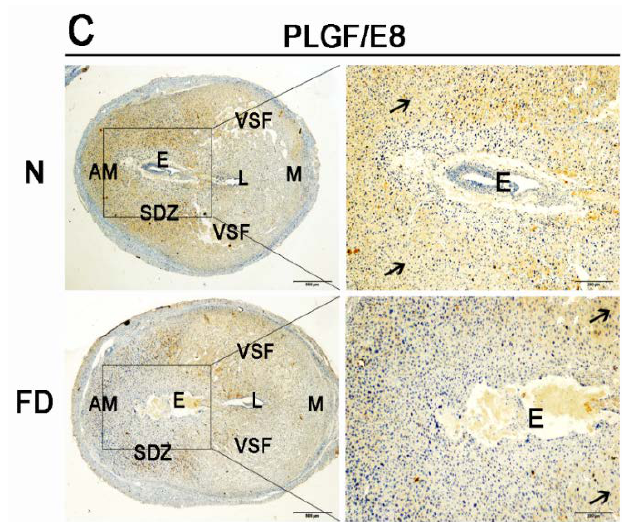
Figure 3. Immunohistochemistry staining with vascular endothelial growth factor A (VEGFA), vascular endothelial growth factor receptor 2 (VEGFR2), and placental growth factor (PLGF). Decreased expression of VEGFA, VEGFR2, and PLGF was detected in the folate-deficient group. The pictures in the right column are the higher magnification images of the black boxes in the left column. Additionally, the black boxes were the uterus’s central region around the embryo. Arrow indicates each factor’s different expression and distribution between two groups. ( A ) VEGFA was localized to a wide area of the secondary decidual zone (PDZ) and the embryo in both normal and folate-deficient mice, but there was decreased expression in the folate-deficient group. ( B ) VEGFR2 was localized mainly to the VSF close to the AM region in normal mice, whereas VEGFR2 was localized mainly to part of the PDZ in folate-deficient mice. ( C ) PLGF had a similar localization pattern as VEGFA in normal mice but was not expressed in the embryo. However, PLGF was expressed mainly in the central region of the uterus instead of in the PDZ in folate-deficient mice. N: normal group; FD: folate-deficient group; E: embryo; L: luminal epithelium; SDZ: secondary decidual zone; M: mesometrial; AM: anti-mesometrial; VSF: vascular sinus folding. Scale bar: 500 µ m (left), 200 µ m (right).